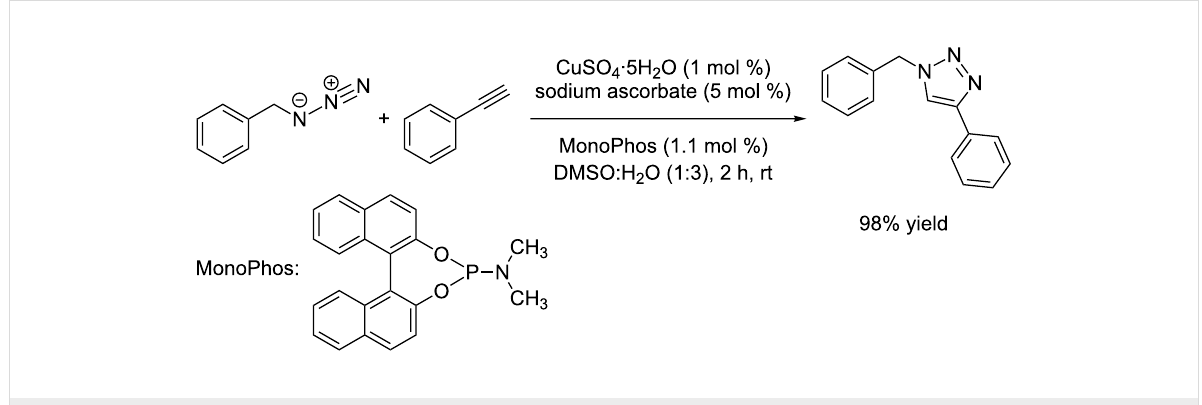
Scheme 4: CuAAC reaction with copper(II) precursor salt and rate-accelerating monodentate phosphoramidite ligand MonoPhos [85].